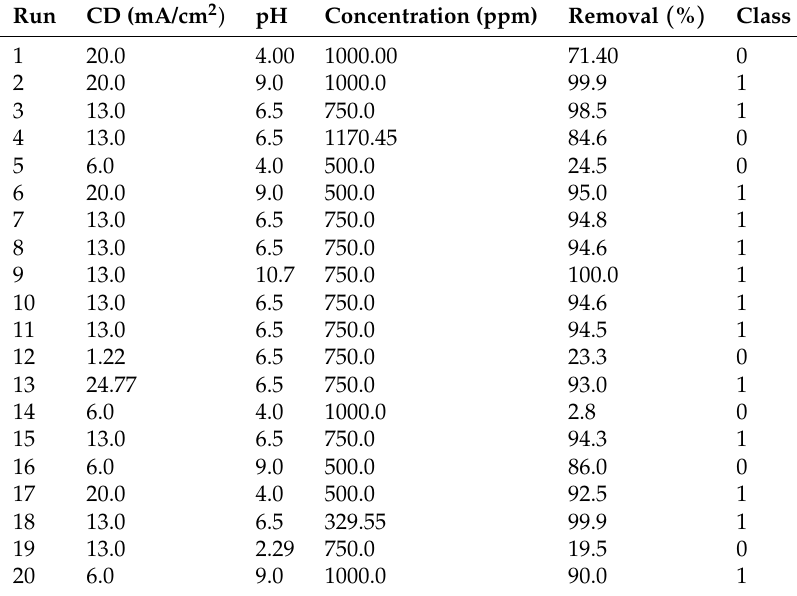
Table 1. Training